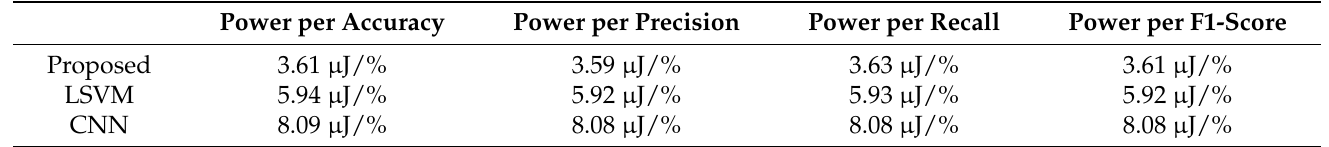
Table 2. Power consumption per evaluation metric of the proposed, LSVM, CNN model. Lower value means more power